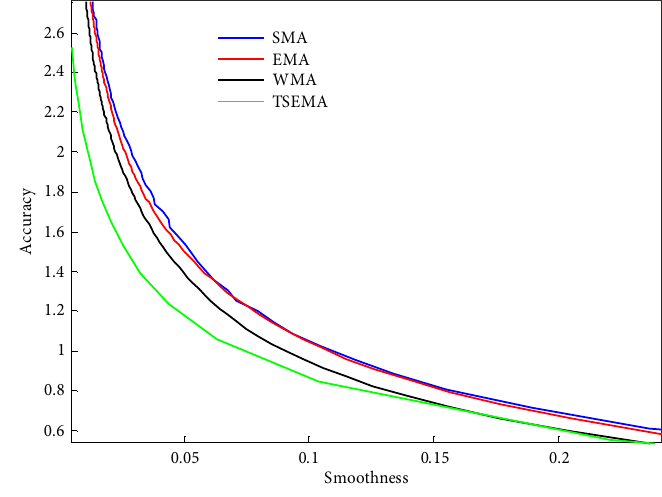
Fig. 3. Smoothness vs. accuracy plotted as one